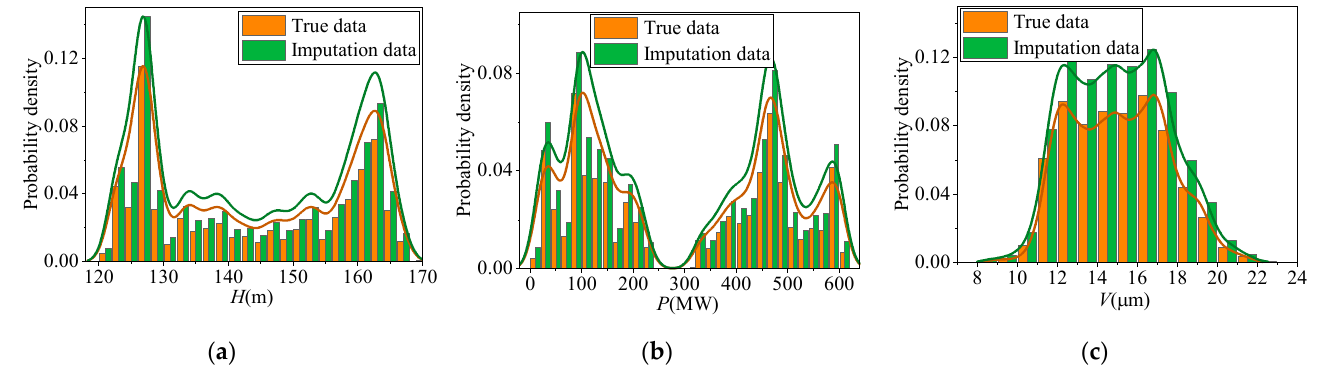
Figure 12. The distribution of data imputation results: ( a ) water head H ; ( b ) active power P ; and ( c ) vibration amplitude of the top cover V . Table 2. Main parameters of the GRUD–WGAN. Parameter Value Length of the input sequence 20 Number of hidden units in the generator 32 Number of hidden units in the discriminator 32 Clipping coefficient 0.01 Epochs of training